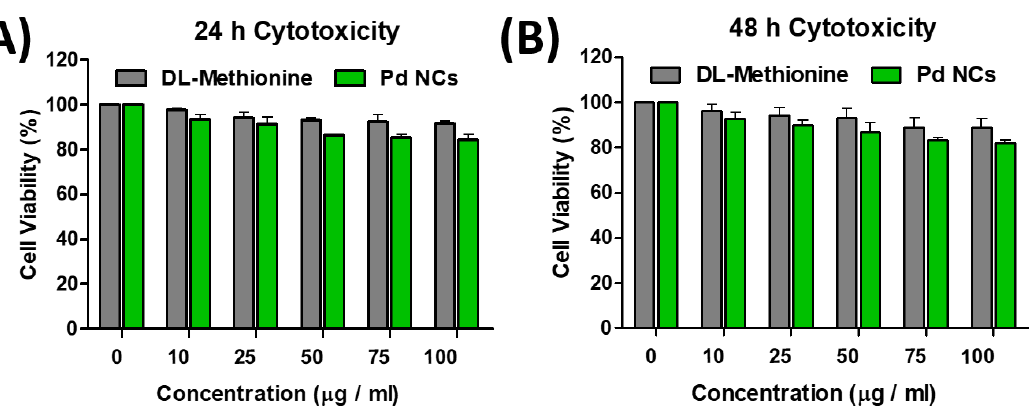
Figure 4 . In vitro cytotoxicity studies in human cervical cancer cells (HeLa) cancer cells. ( A , B ) represents the percentage cellular viabilities of DL-Methionine capped Pd NCs internalized HeLa cells at 24 and 48 h incubation times, respectively. The error bars indicate the standard deviation (SD) values obtained from four replicates (n = 4) for each set of concentration respectively.